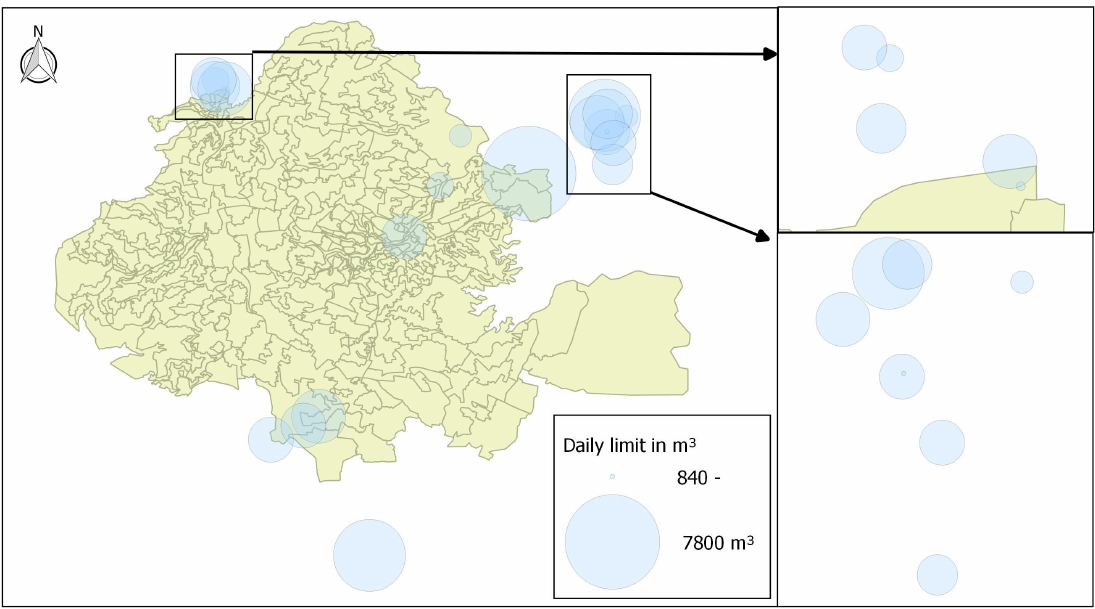
Figure 3. Groundwater wells in the model and their assumed abstraction limit per